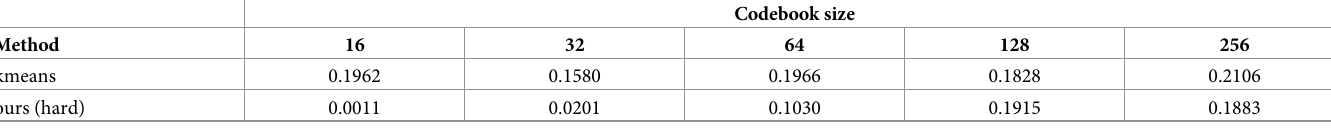
Table 10. The objective values of the k-means and ours with the hard objective with respect to the codebook size on the